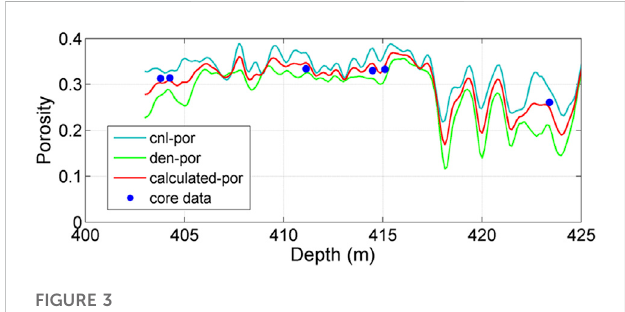
FIGURE 3 Calculated porosity log. The cyan line indicates the CNL-log predicted porosity, the green line indicates the density-log predicted porosity, and the red line indicates the estimated porosity using the current method. It is clear that the estimation matches the laboratory measureddata,demonstratingthereliability oftheestimation results.